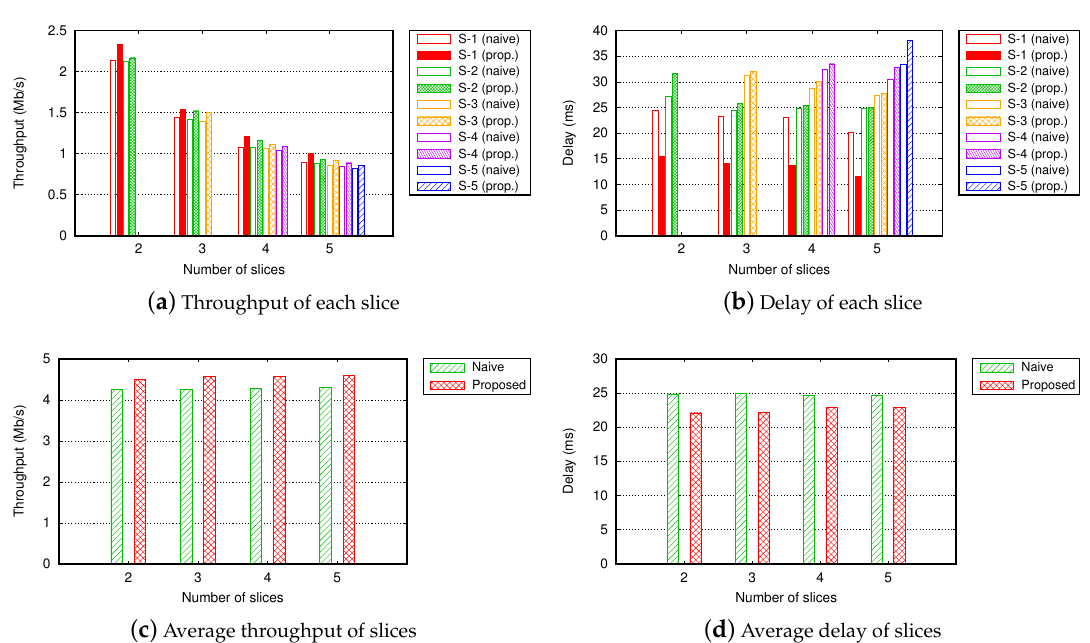
Figure 9. Throughput and delay according to a number of slices in a random topology (number of total flows = 40, Γ = ∞